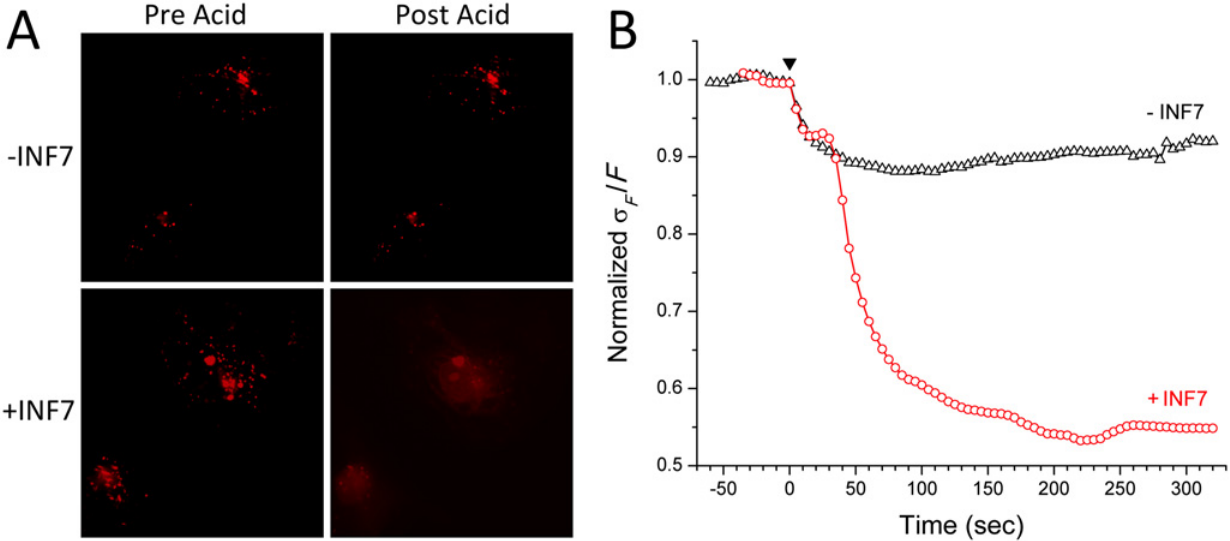
Fig 4. Activating endocytosed INF7 with acetic acid causes endosomal escape of SR into the cytosol. A. Liposomes containing SR with or without INF7 were incubated with CV1 cells for 1 hr, washed with Ca 2+ /Mg 2+ -free HBSS containing 1 mM EDTA, and imaged by fluorescence microscopy (Pre Acid); endosomal SR appears as fluorescent puncta. After the addition of 1% acetic acid to the extracellular solution, fluorescence in cells incubated with INF7-containing liposomes (+INF7) becomes cytosolic and more homogeneous. In contrast, in cells incubated with liposomes lacking INF7 (-INF7), the appearance of SR fluorescence is unchanged by acidification. B. Time course showing changes in SD of pixel intensity relative to mean intensity ( σ /F , normalized to mean baseline value before acidification at time 0). Time of addition of acetic acid is indicated by the black arrowhead. Activated INF7 rapidly releases SR into the cytosol, and the more homogeneous distribution of SR leads to lower SD values than in the case of incubation without INF7, where SR remains confined to endosomal compartments. Also see S1 and S2 Videos in Supporting Information.